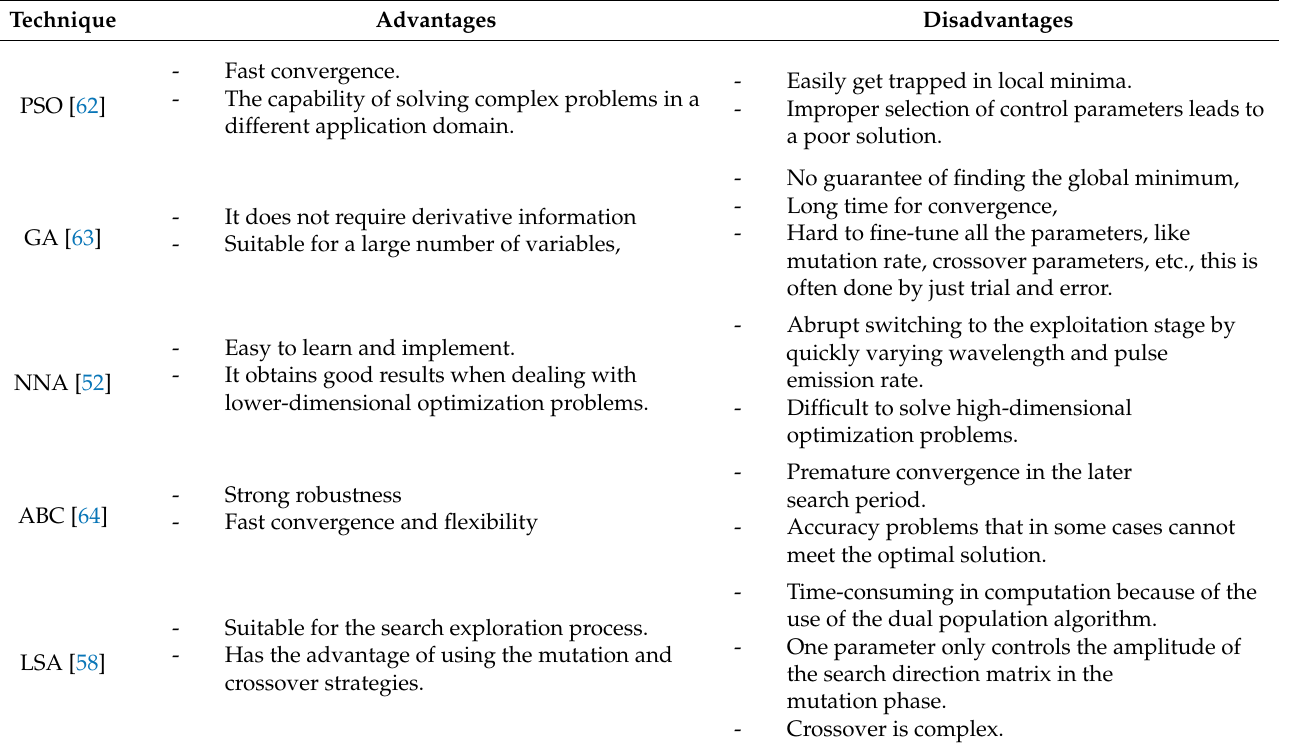
Table 1. Advantages and disadvantages of the most popular nature-inspired optimization techniques.